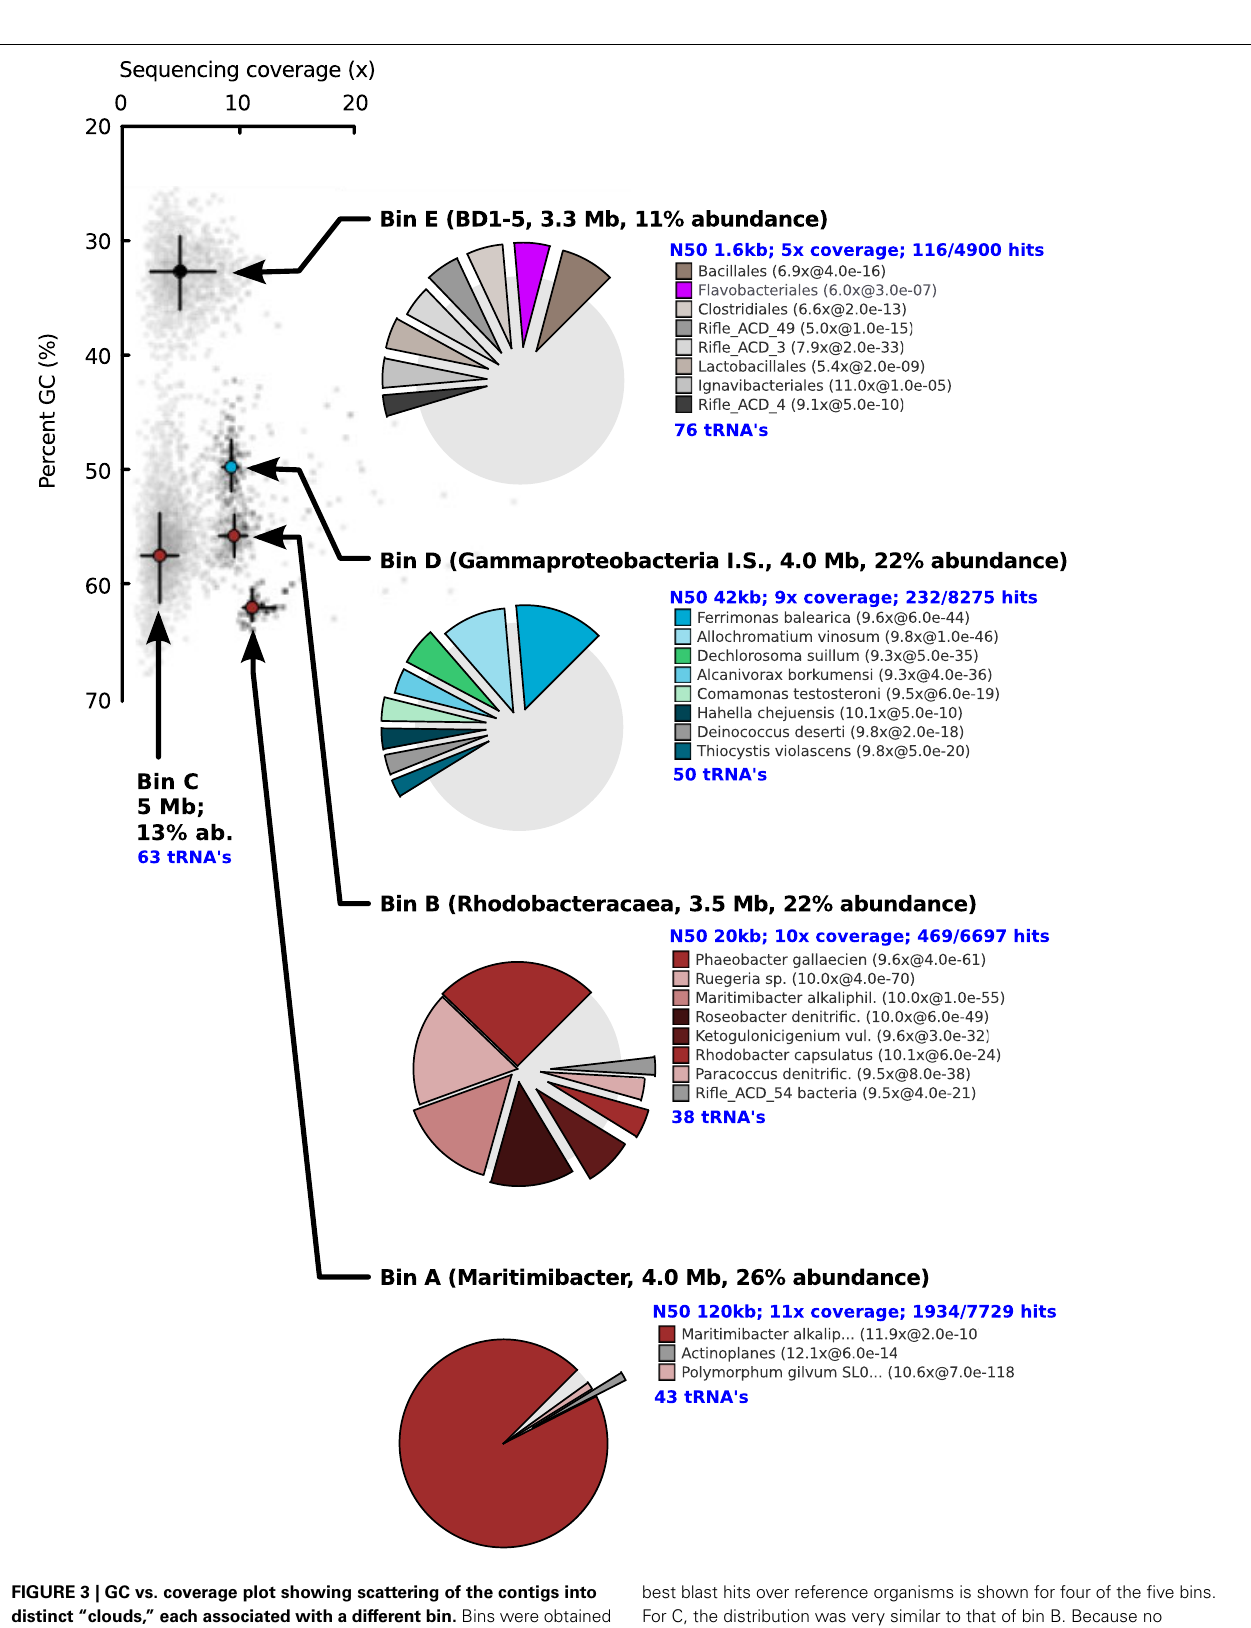
best blast hits over reference organisms is shown for four of the five bins. For C, the distribution was very similar to that of bin B. Because no phylogenetically close reference organisms were present in the database for Bin D and E, many contigs of these bins did not give a blast hit.